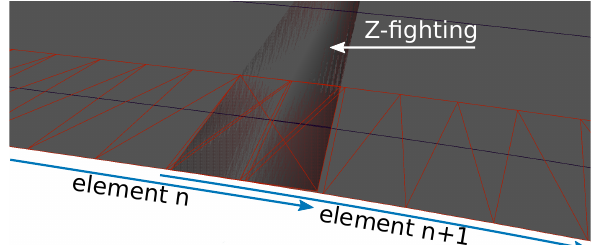
Figure 14. Lane surface overlap caused by a gap between geometry element n and n + 1 of the reference line.